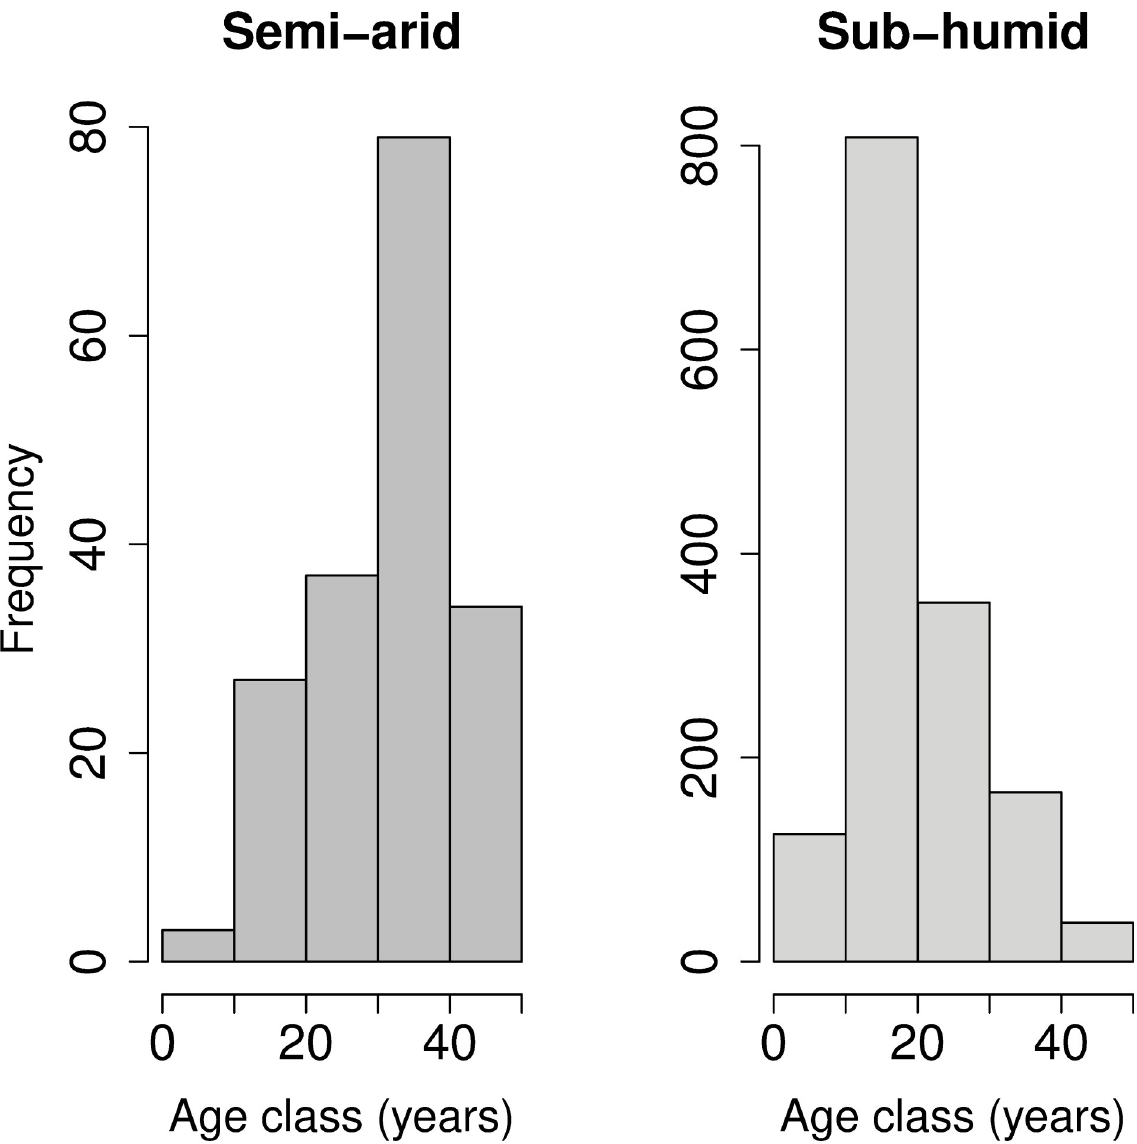
Fig 1. Age structure of Quercus ilex recruits in the two precipitation levels, grouped in 10-year